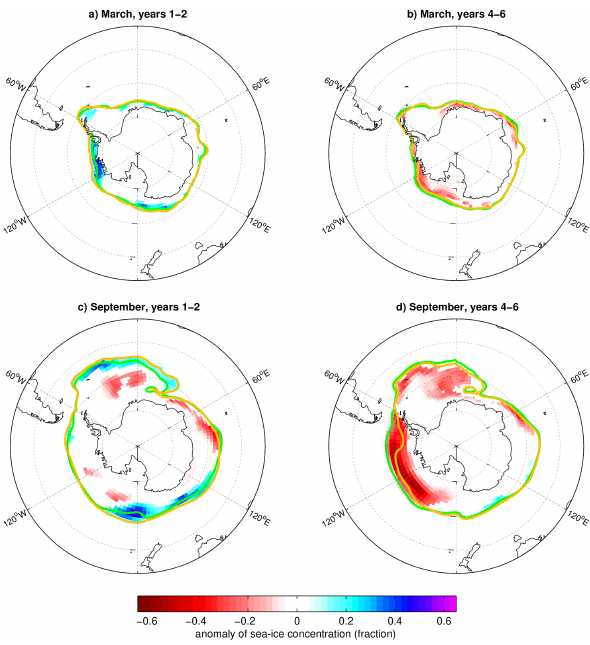
Figure 6. Ensemble-mean simulated March (top panels) and September (bottom panels) Antarctic sea-ice concentration anoma- lies for integration years 1–2 (a, b) and 4–6 (c, d) of the SUPER1 ensemble. Only grid points where the anomaly is significant at 95% confidence ( n = 5; see methods) are shown. The green and or- ange lines indicate, respectively, the pre-eruption average and post- eruption average sea-ice edge.